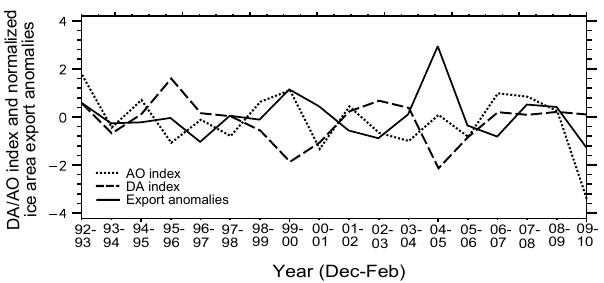
Fig. 8. Sea level pressure fields (mb) for a month of comparatively Fig. 11. Time series of winter (December - February) Dipole Anomaly (DA) and Arctic Oscillation (AO) index vs. normalized monthly high (a) March 2007 and low ice area flux rates (b) April 1998 and anomalies of detrended total ice area flux out of the Laptev Sea from 1992 to 2010. across the northern and eastern